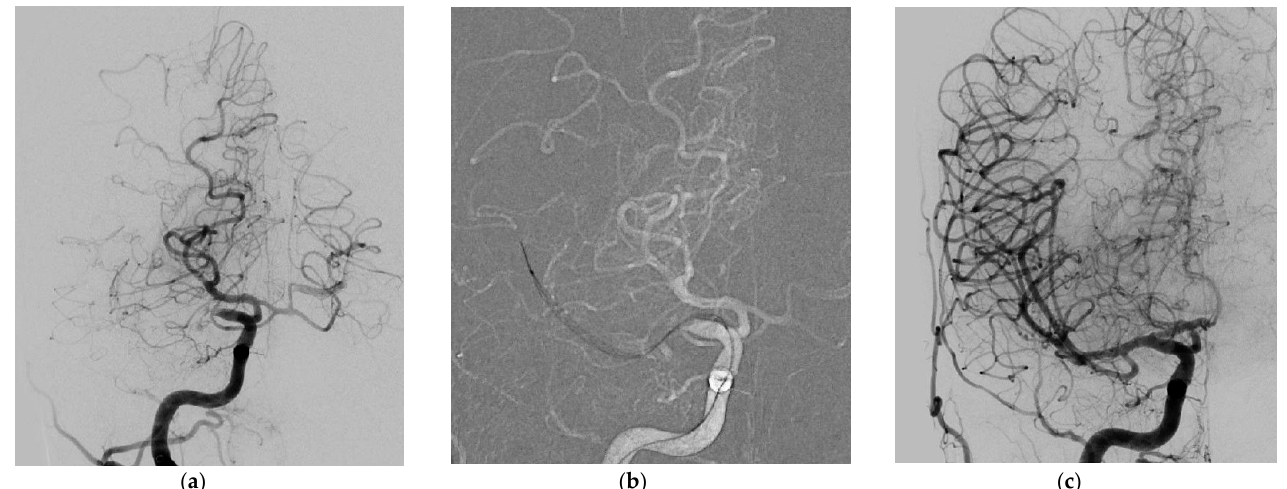
Figure 2. ( a – c ) ICA terminus occlusion treated successfully with one MTE maneuver using the Tigertriever XL Device. Acute occlusion of the ICA terminus distal to a fetal posterior cerebral artery origin, anterior-posterior view ( a ); Tigertriever XL Device placed within but mainly distal to the thrombus within the ICA terminus, anterior-posterior view ( b ); successful reperfusion after one maneuver (TICI 3), anterior–posterior view ( c ).